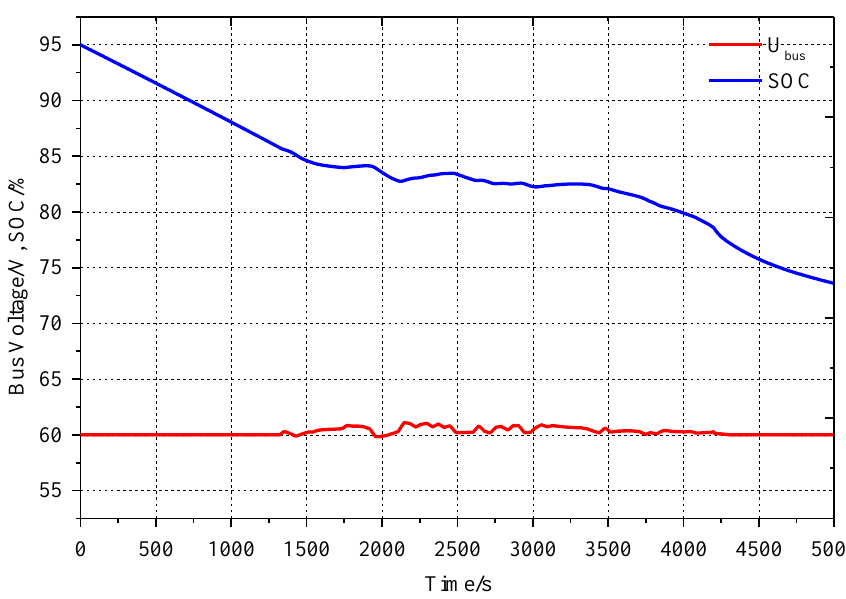
Figure 13. Power flow of the DC microgrid with initial SOC at 95%.